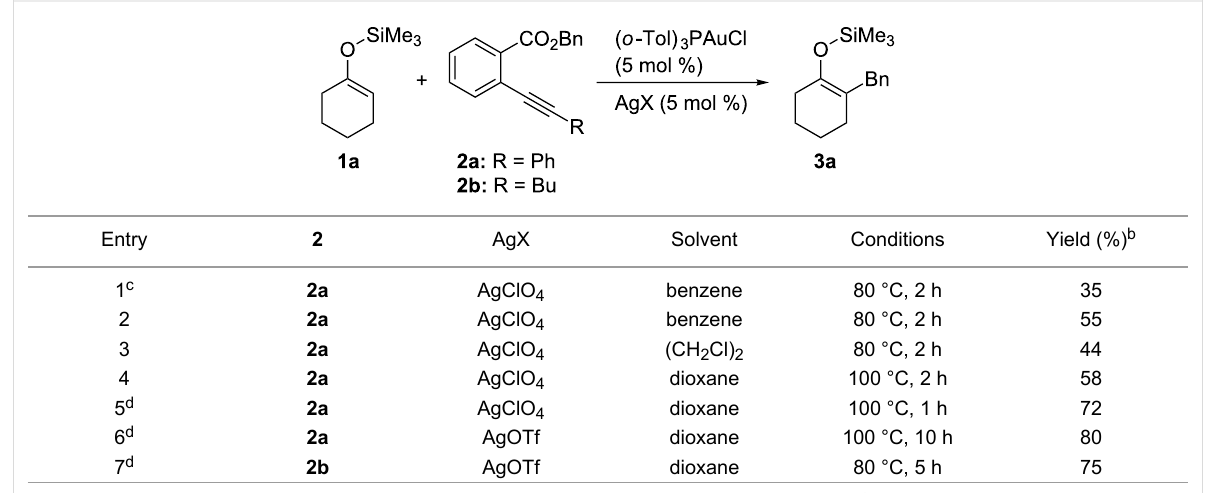
Table 1: Gold-catalyzed alkylation of silyl enol ether a